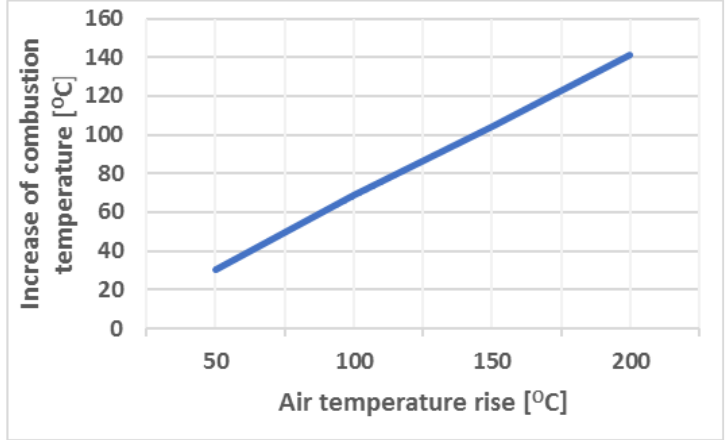
Figure 6. Increase of combustion temperature depending on air temperature [own study].